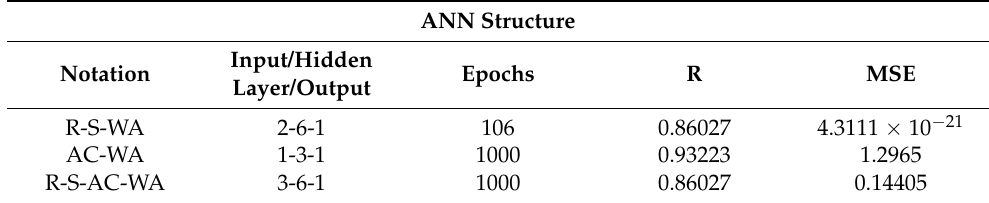
Table 8. Summary of the results of the ANN models.